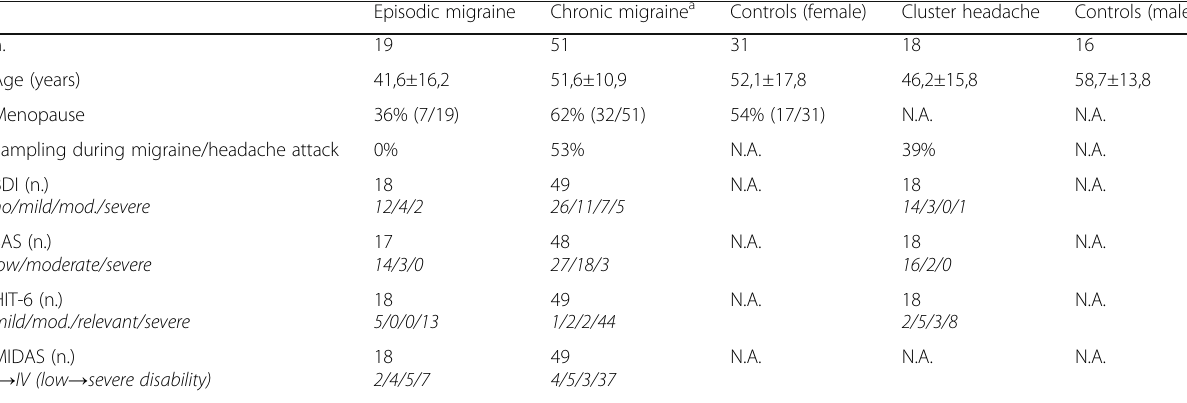
Table 1 Demographic and clinical characteristics of the recruited patients affected by episodic migraine, chronic migraine, or cluster headache, and their respective healthy controls